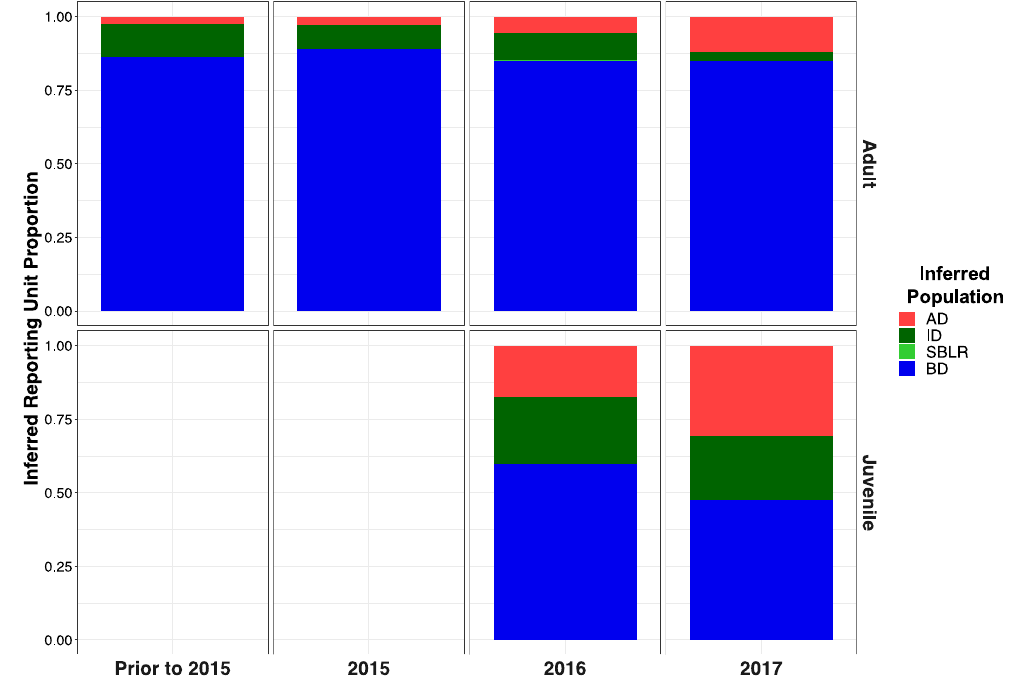
Figure A2. Inferred proportion of genetic ancestry from each of the four inferred populations across recolonizing adult and juvenile steelhead smolt life history cohorts from the GSI analysis (iii). Relative proportions of genetic ancestry from BD populations were greater in adult life history cohorts in GSI analysis (iii) compared to GSI analysis (i) GSI analysis (ii).